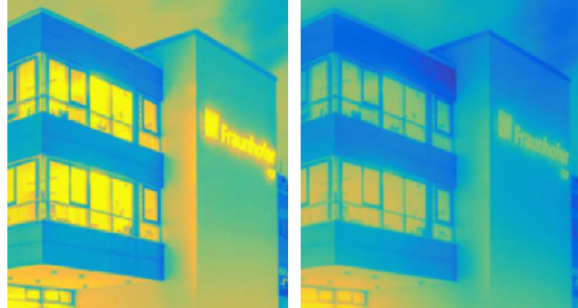
Fig. 3. Image degradation induced by contamination with a PAC of 0.1% for a Gaussian double lens (without aberrations). Left: ideal image, right: degraded